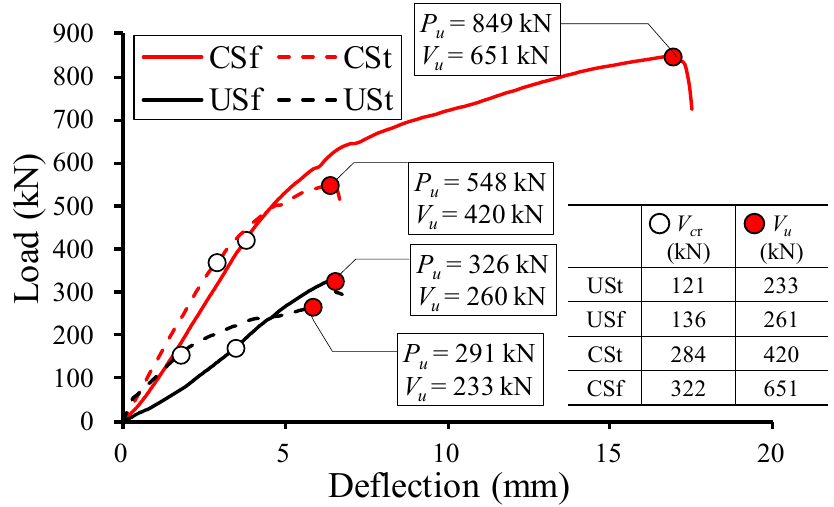
Figure 6. Load-deflection responses of shear test specimens.